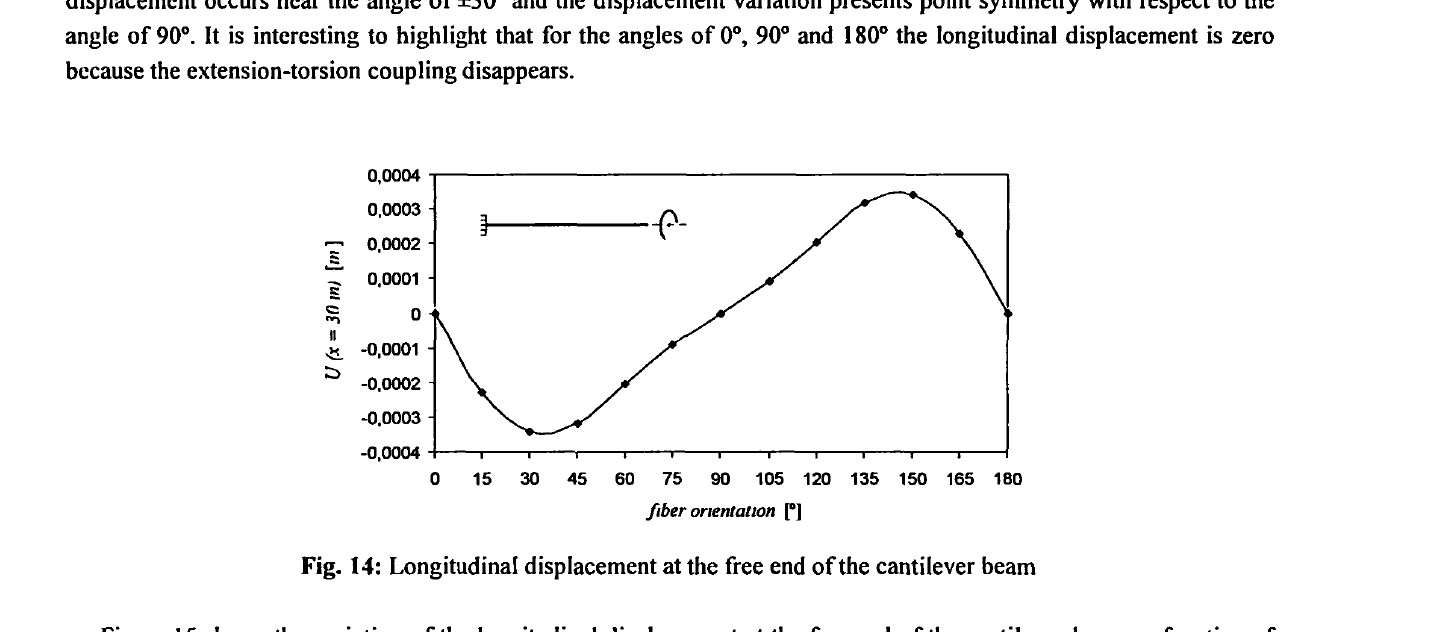
Fig. 14: Longitudinal displacement at the free end of the cantilever